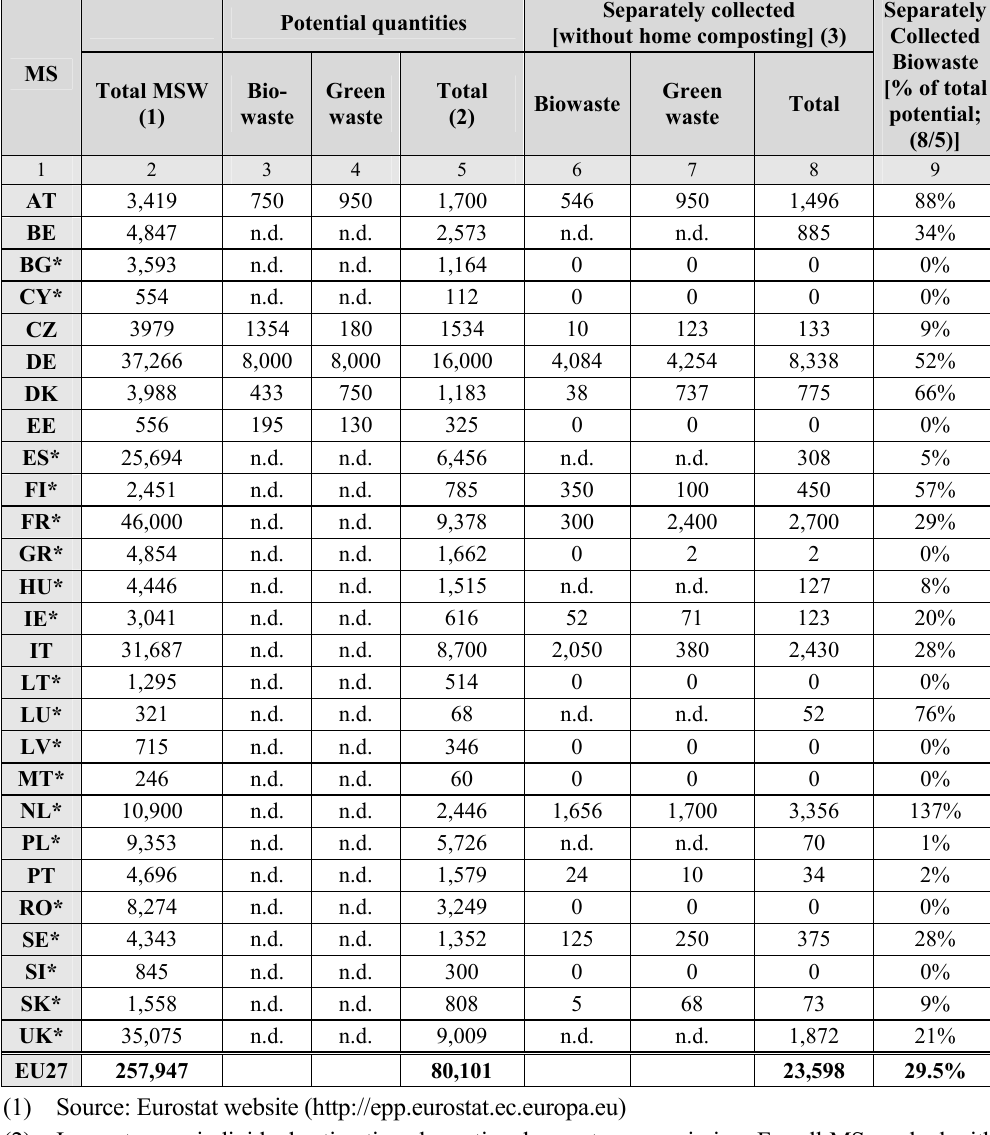
Table 31: Amount of separately collected and composted biowaste and green waste in